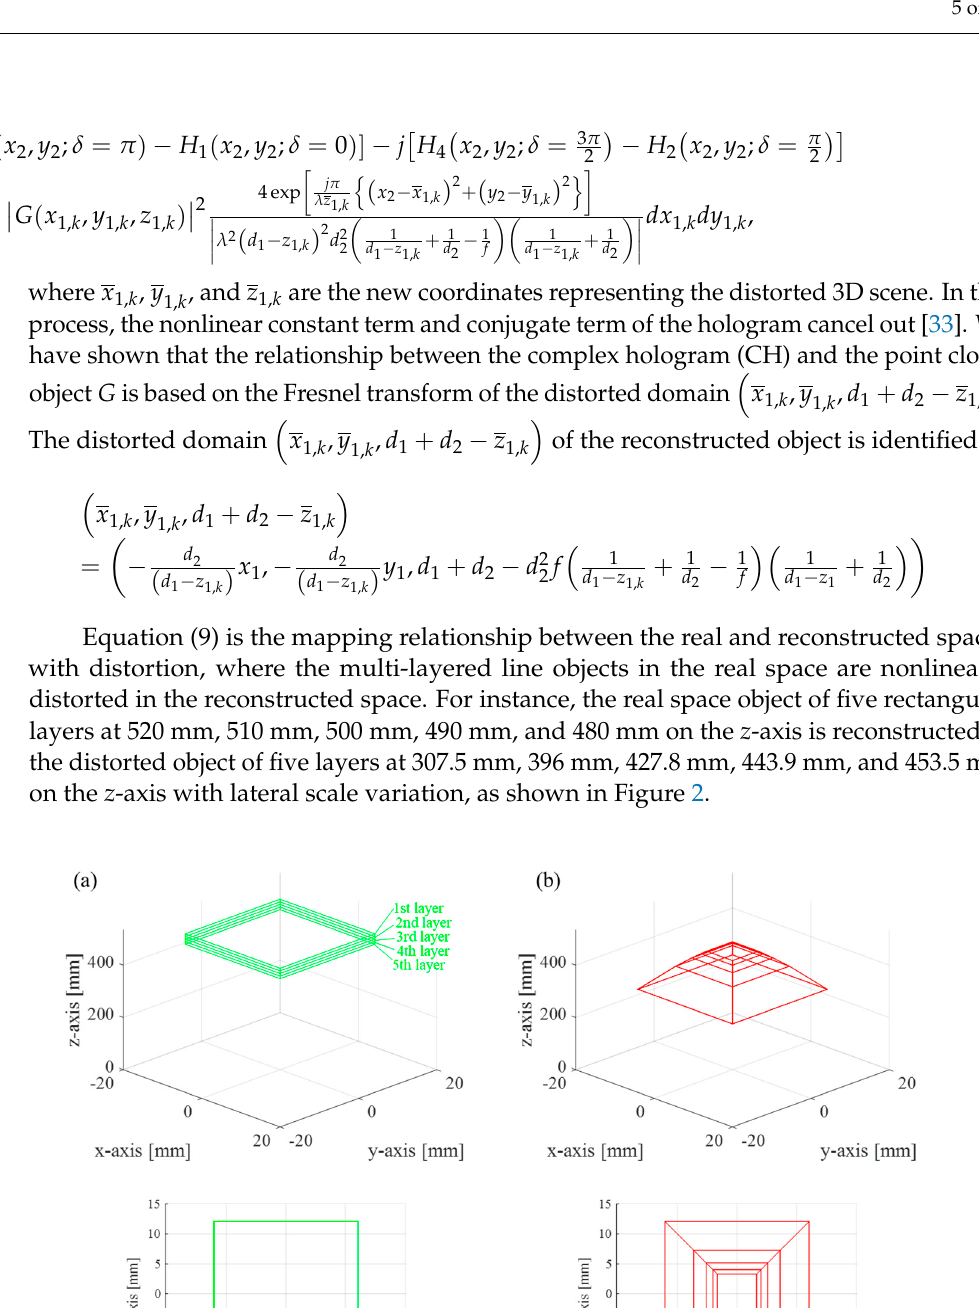
H , are presented in Figure 3. 1